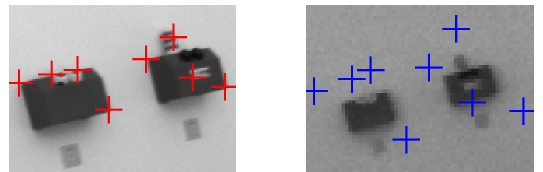
Figure 4. Observed drift of feature tracks over time. Left image: Red crosses mark detected features. Right image: Blue crosses mark the tracked features after 160 images (camera facing back- wards).